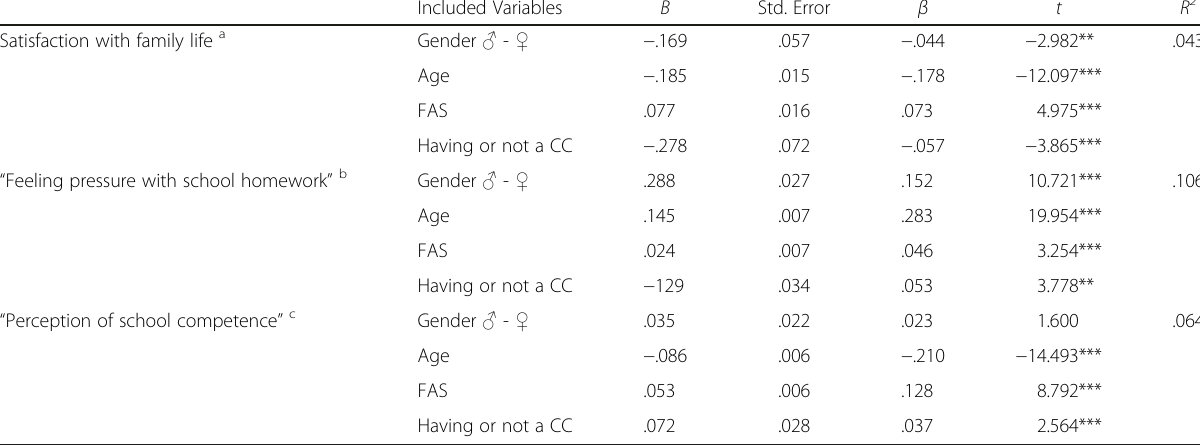
Table 5 repeat the same models but instead of the vari- able having/not having a CC, it considers whenever “ CC affects/not affects school participation ” . Table 4 Predicting 1) Adolescents ’ satisfaction with family life and 2) “ Feeling pressure with school homework ” and “ perception of